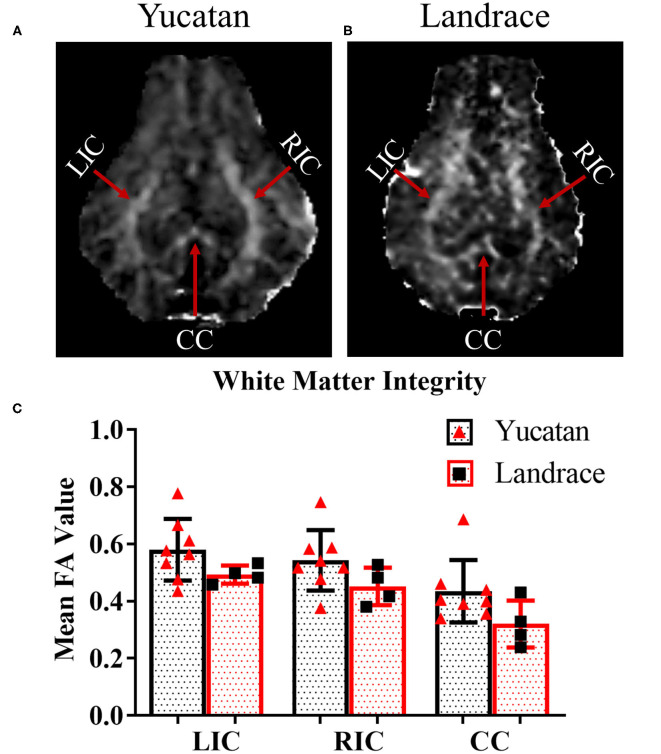
White matter integrity in major tracts of YC and LR pigs are comparable. Pre-stroke FA maps for YC (A) and LR (B) pigs showed no significant differences in mean FA values in major white matter tracts (C) LIC, left internal capsule; RIC, right internal capsule; and CC, corpus callosum. Red arrows indicate major tracts as noted in (A,B). *Significant difference between breeds.